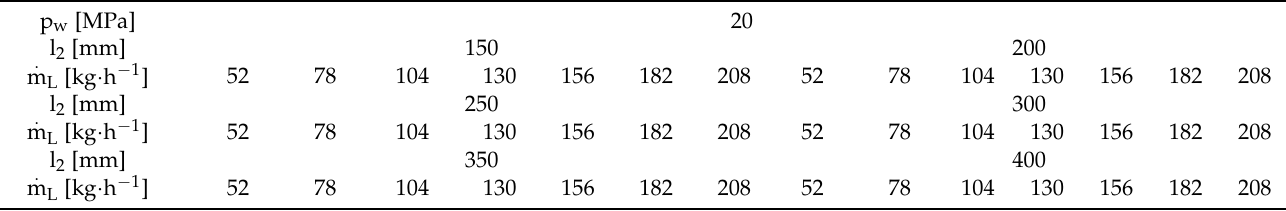
Table 2. Sample test variants for p w = 20 MPa, κ = 90 ◦ .